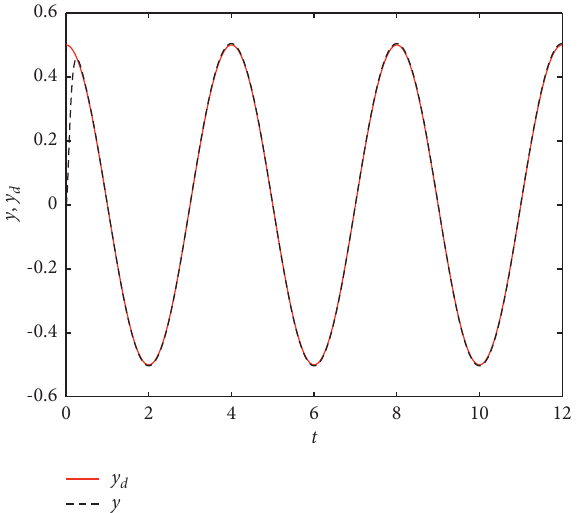
Figure 1: The reference signal y